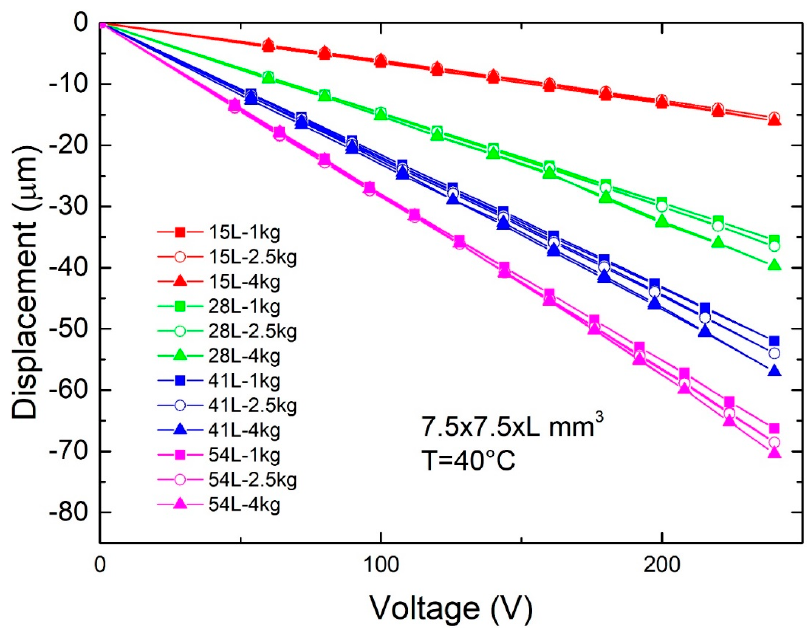
Figure 8. Same as Figure 6 but tested at 40 °C.